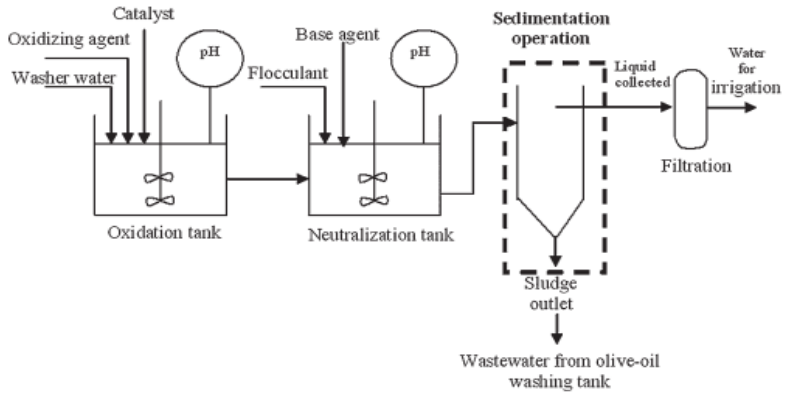
Figure 3. Sludge separation after OMW oxidation process. Reprinted with permission from Refer- ence [56]. Copyright 2008. Wiley and